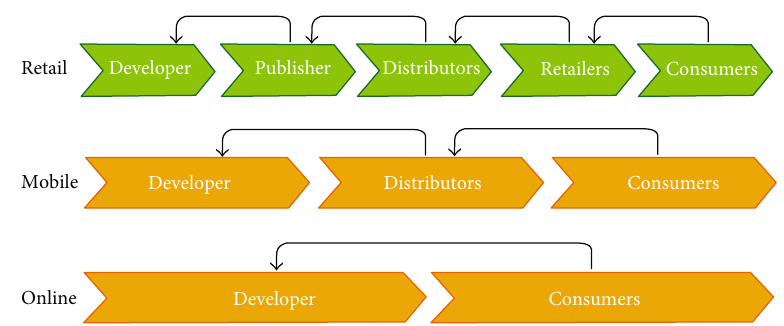
Figure 1: Comparison between di ff erent game value chains